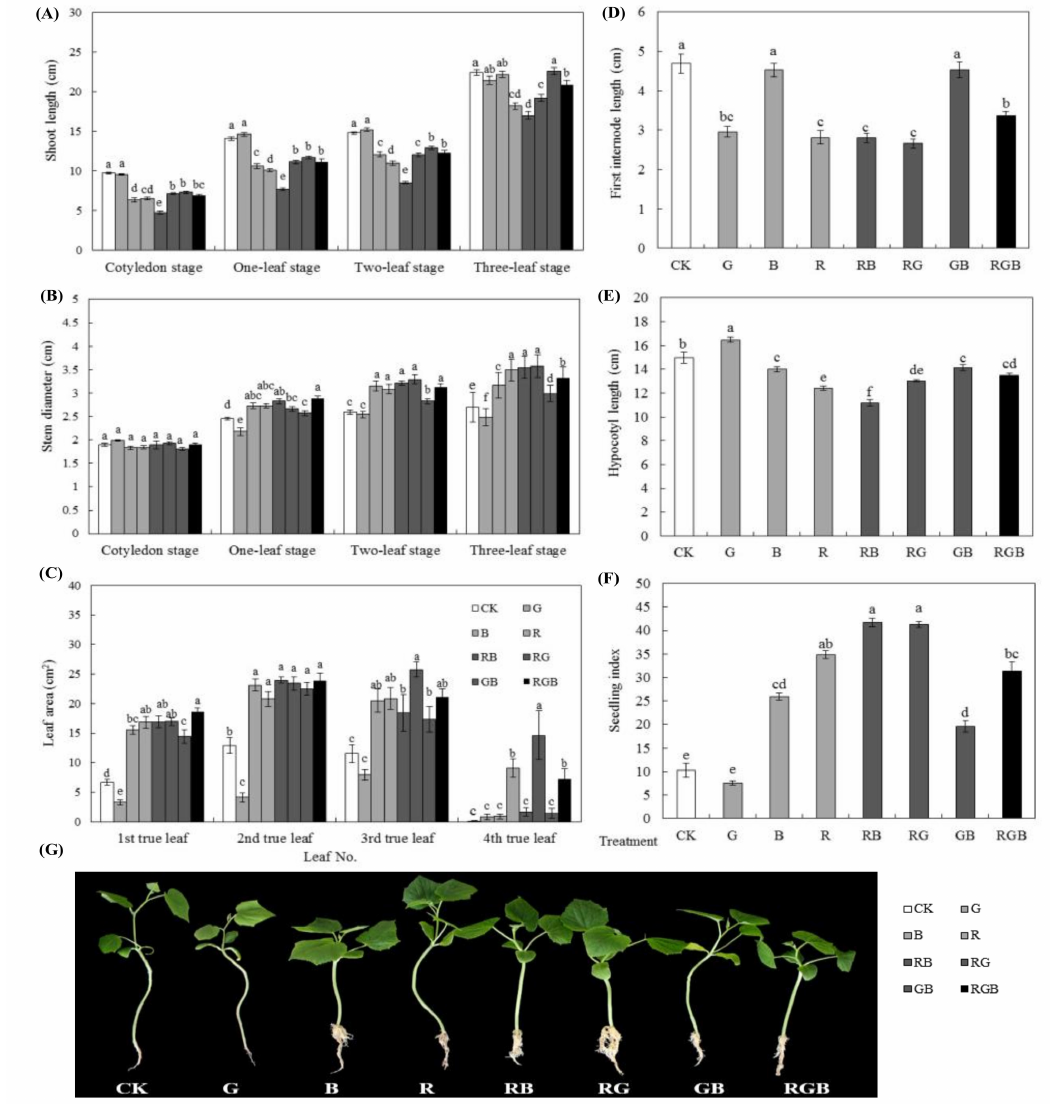
Figure 1. E ff ects of supplemental light quality on morphological parameters of cucumber seedlings under extremely low irradiance (ELI), including shoot length ( A ), stem diameter ( B ), leaf area ( C ), first internode length ( D ), hypocotyl length ( E ), seedling index ( F ) and growth vigor of cucumber seedlings ( G ) in experiment 1. Di ff erent letters indicate statistically significant di ff erences among treatments ( p ≤ 0.05). Error bars show SE ( n =